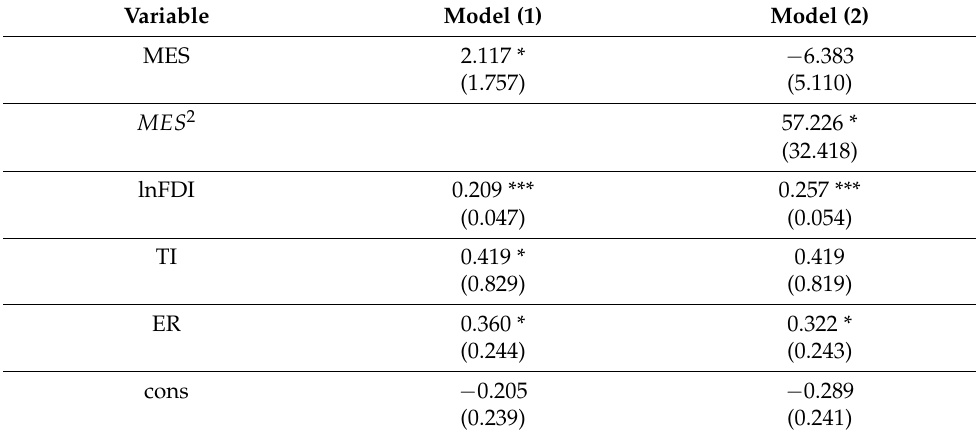
Table 6. Tobit regression results for external driving forces of mining